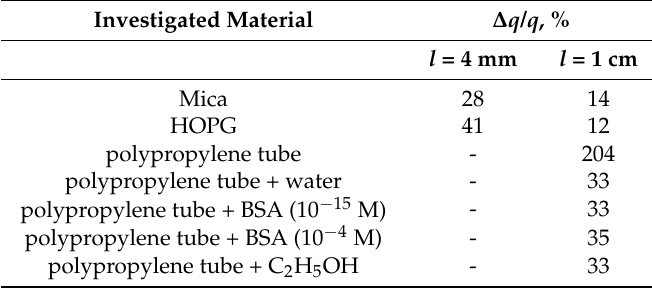
Table 1. Values of charge accumulated in the cell in the presence of various materials,